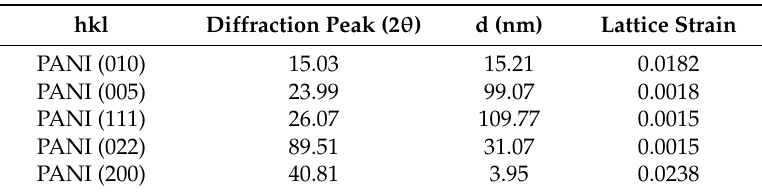
Table 5. Crystallinity proprieties of the PANI 8